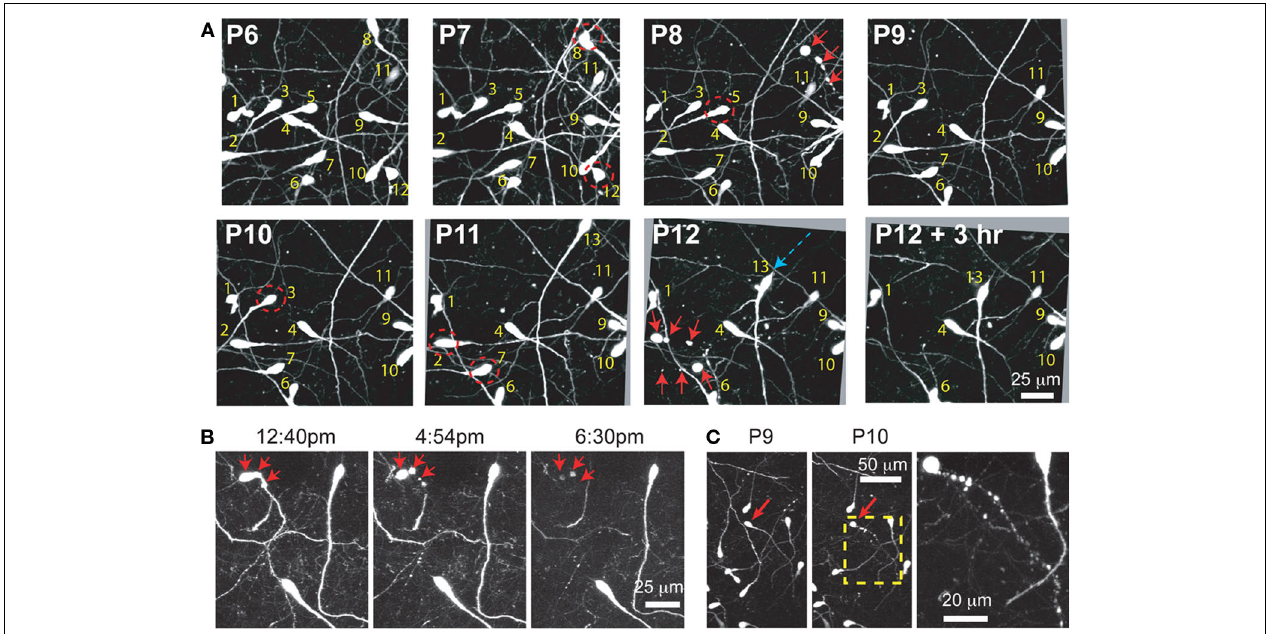
FIGURE 5 | Time-lapse imaging in Ebf-GFP mice confi rms the death of identifi ed CR neurons by apoptosis. (A) Serial imaging of an Ebf2-GFP mouse with in vivo two-photon microscopy to re-identify the location of individual CR neurons from P6 to P12. All images are MIPs of 30 slices, 2 µm apart. Note that CR neurons exhibit slight movements of the soma in the xy plane (blue arrow shows a large single day retraction of the soma of cell 13), but do not migrate over longer distances in the xy or z planes. Note also the disappearance of CR